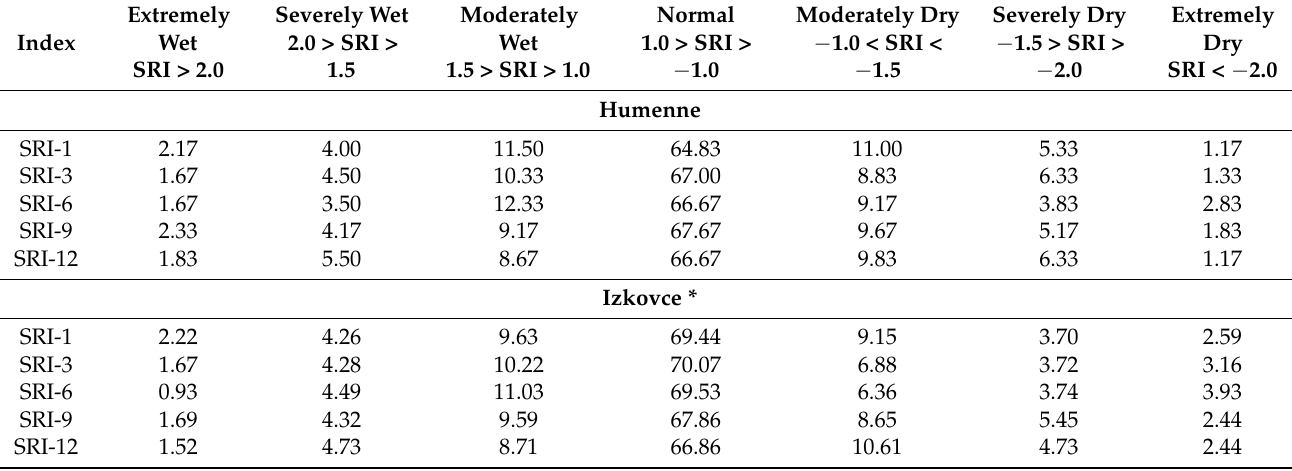
Table 8. SRI parameters over various time scales for the Humenne and Izkovce hydrological stations in the period 1970 −